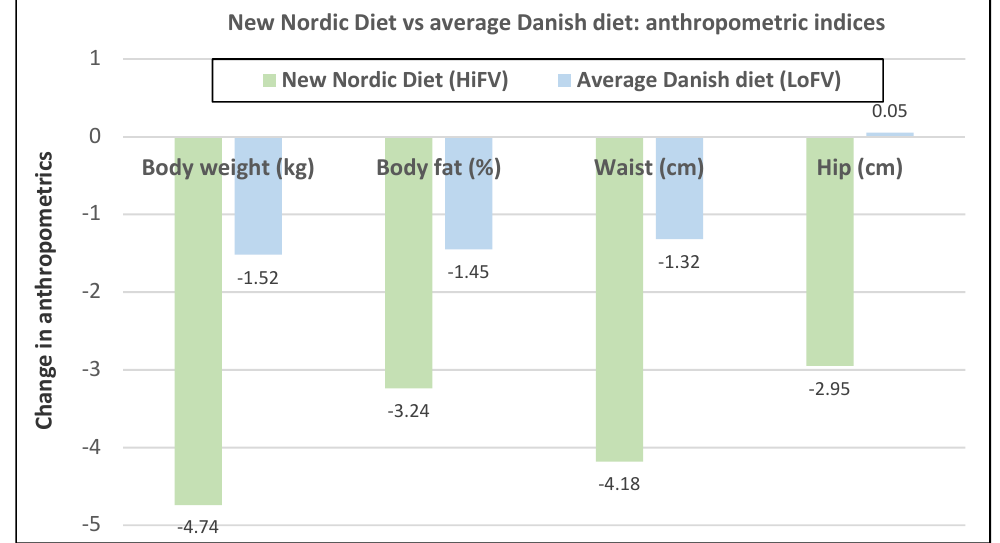
both systolic and diastolic blood pressure by −5.1 and −3.2 mmHg, respectively.